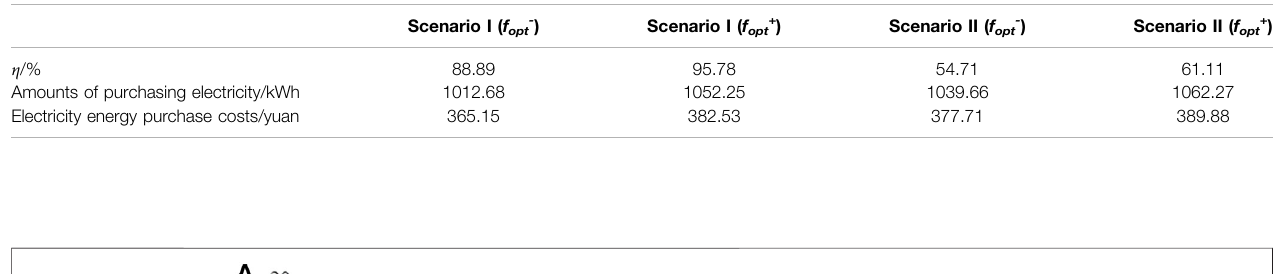
TABLE 3 | Optimal scheduling results of Scenario I and Scenario II.